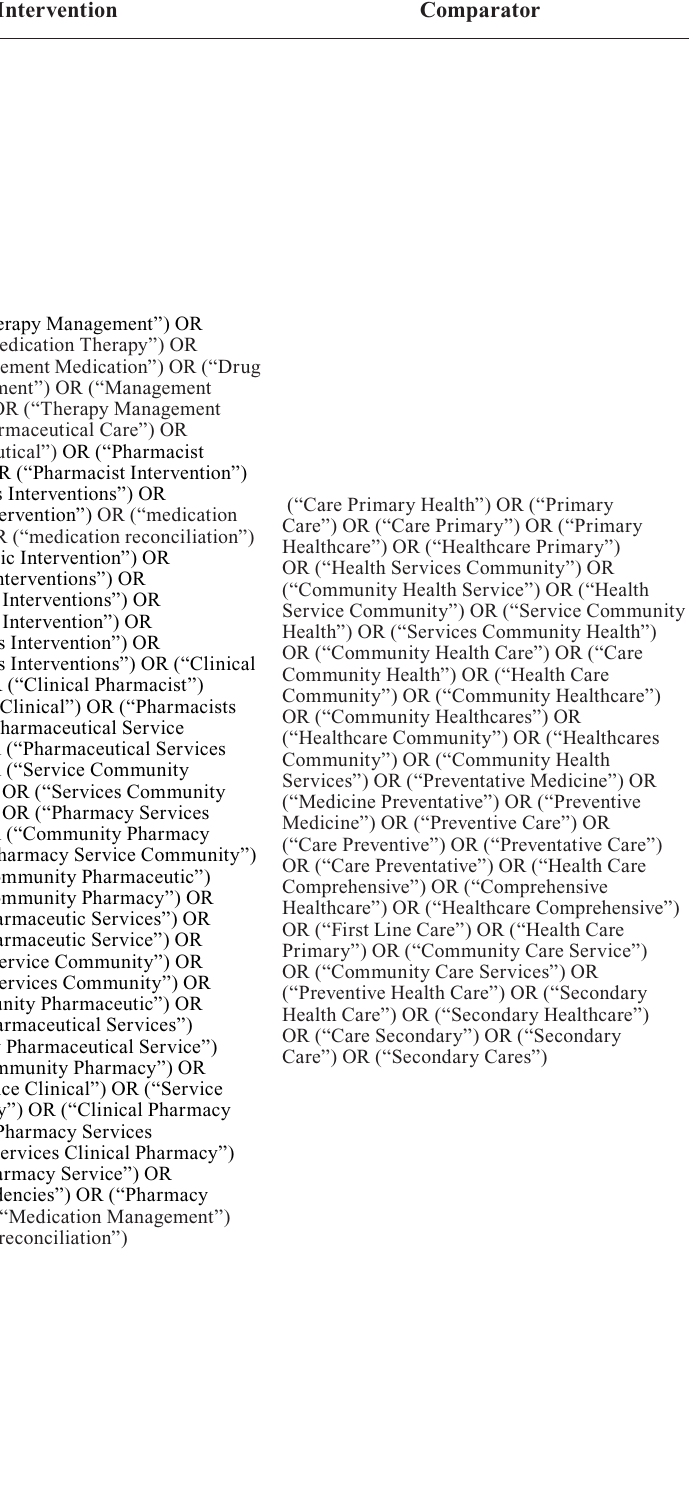
Population Intervention